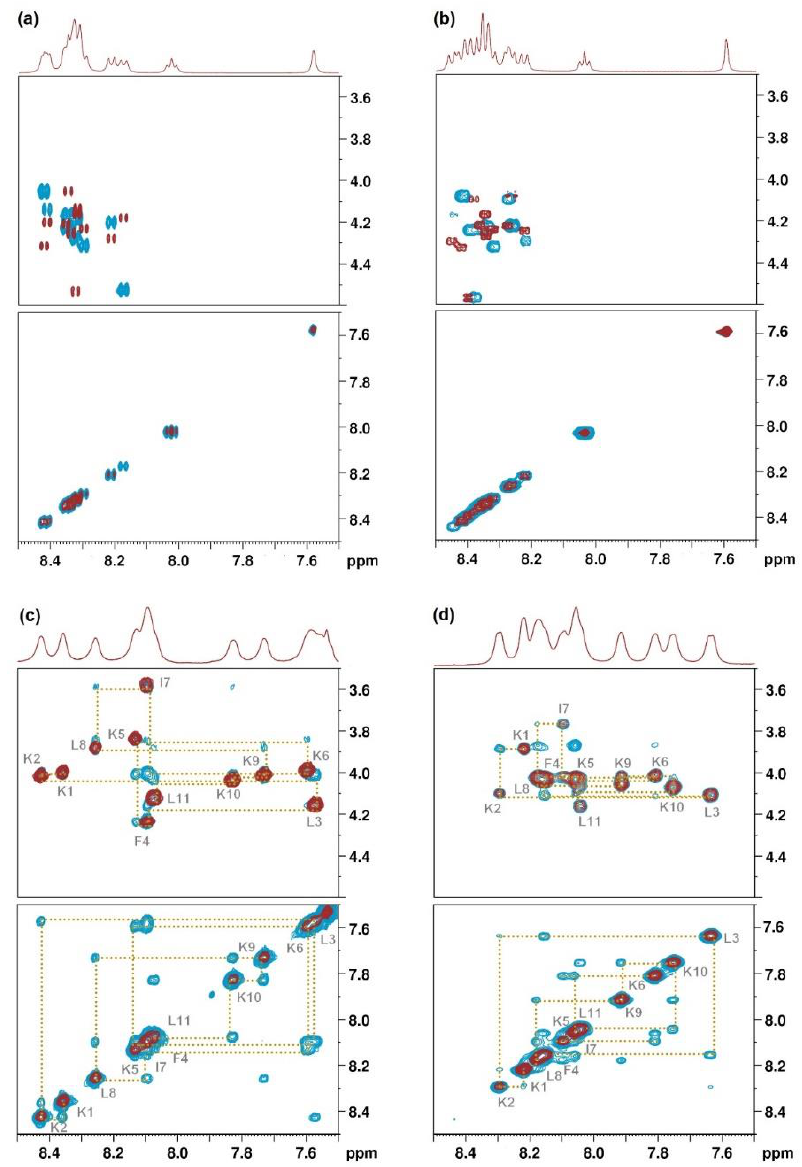
Figure 2. Overlay of HN-HN and HN-H α TOCSY (red) and NOESY (blue) correlations for ( a ) BP389 and ( b ) BP475 in phosphate buffer; ( c ) BP389 and ( d ) BP475 in phosphate buffer with 30% CF 3 CD 2 OD.